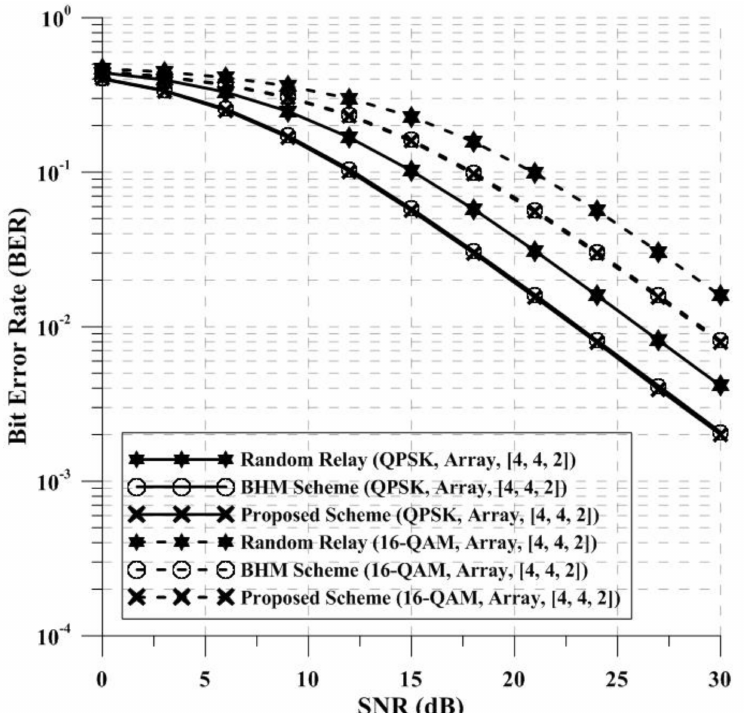
Figure 8. The BER performance of the proposed and conventional schemes in 3D channel environment (Array